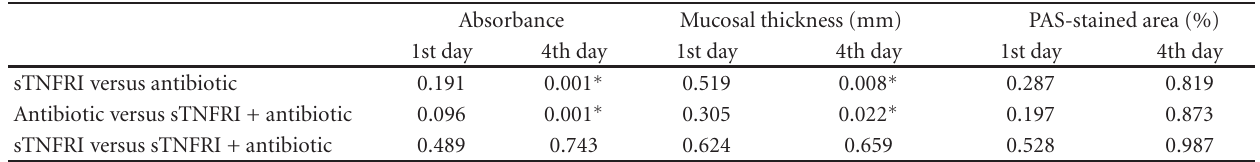
Table 4: Significance of di ff erences ( P value) in histopathological variables between treatments. Absorbance